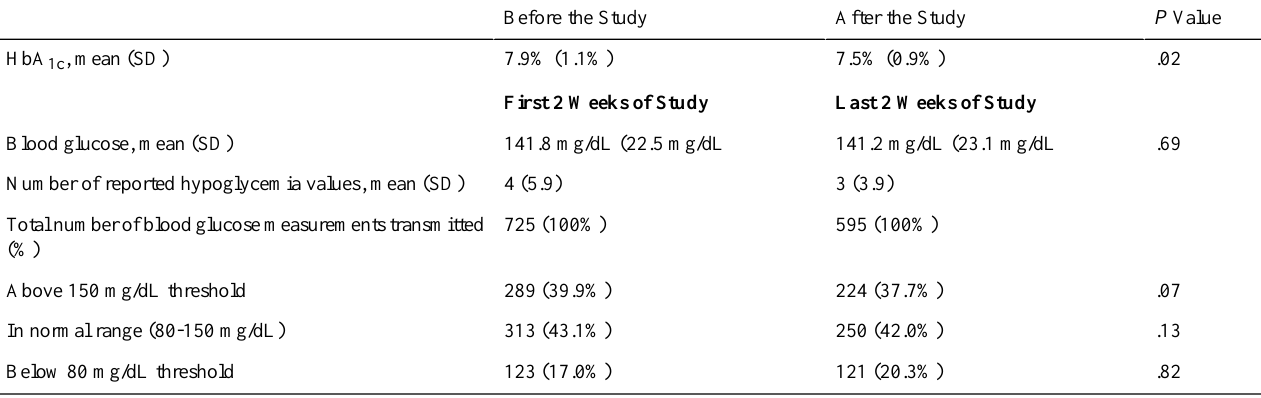
Table 3. Metabolic control: comparing the first and last 2 weeks of the study period